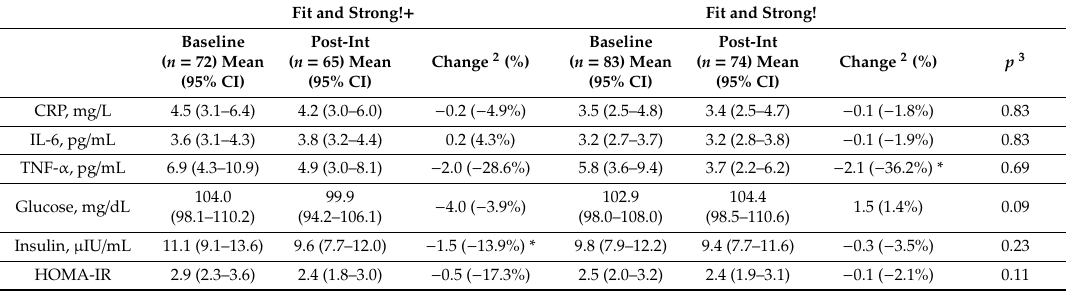
Table 3. Cancer-riskbiomarkervariables: adjusted 1 geometricmeansatbaselineandpost-interventionvisits. Fit and Strong! + Fit and